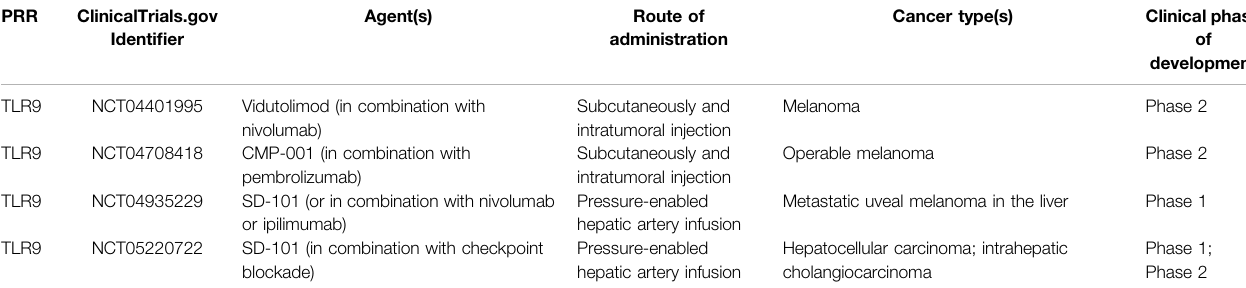
TABLE 1 | ( Continued ) Summary of clinical trials of nucleic acid-sensing pathways-related agonists.